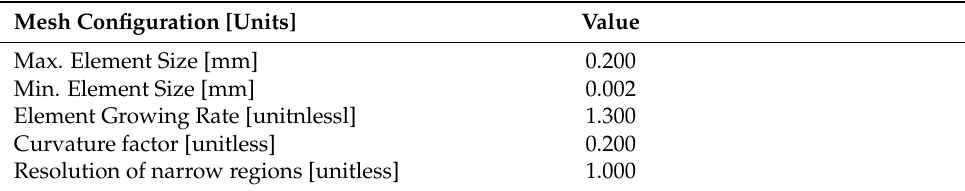
Table 1. Mesh Configuration